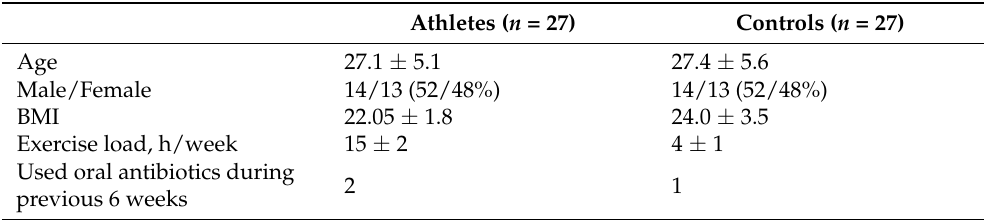
Table 1. Clinical characteristics of the study population. Values are represented as mean ± SD or as n of